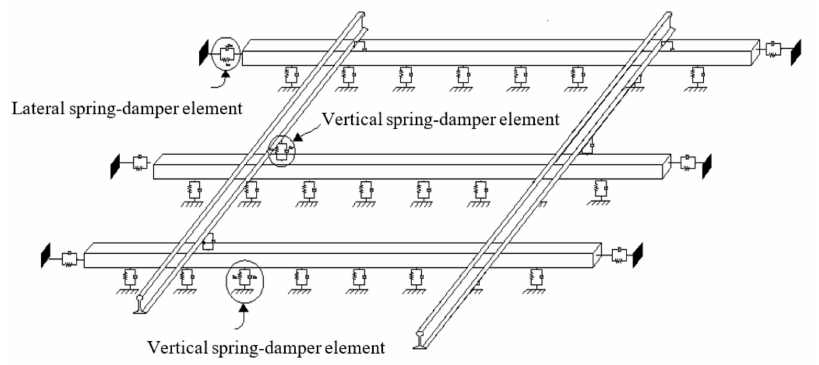
Figure 7. Track dynamics model.